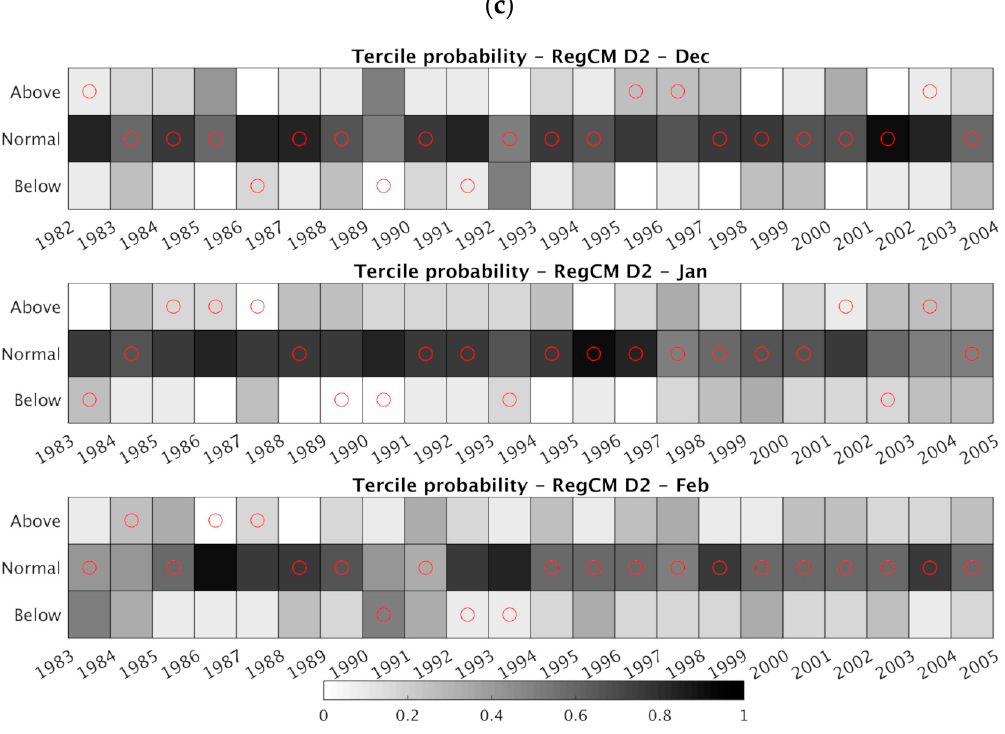
Figure 13. The same as in Figure 6 but for the precipitation. Tercile plots for the CFSv2, RegCM-d1, and RegCM-d2 temperature winter months climatology (sub panels a, b, and c respectively).